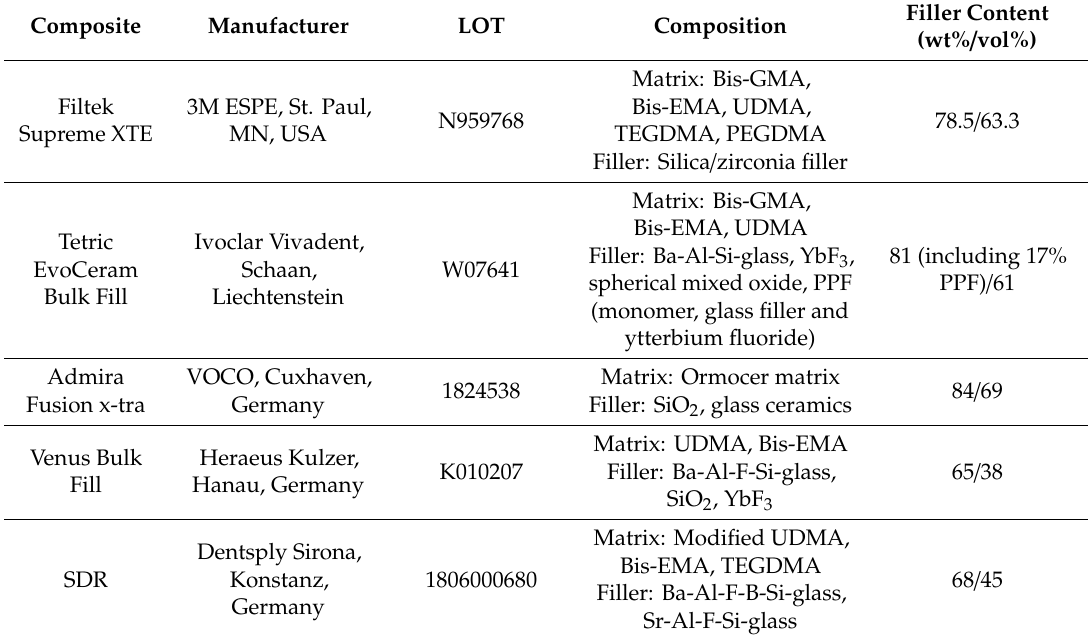
Table 1. Manufacturers’ information on the composite materials used in this